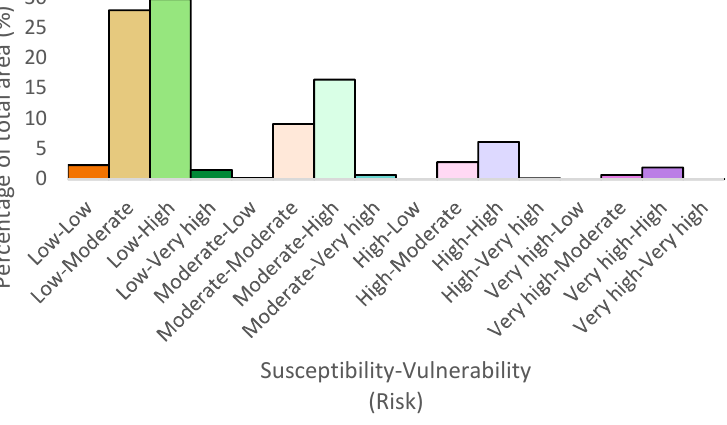
Figure 7. Area percentage of each risk